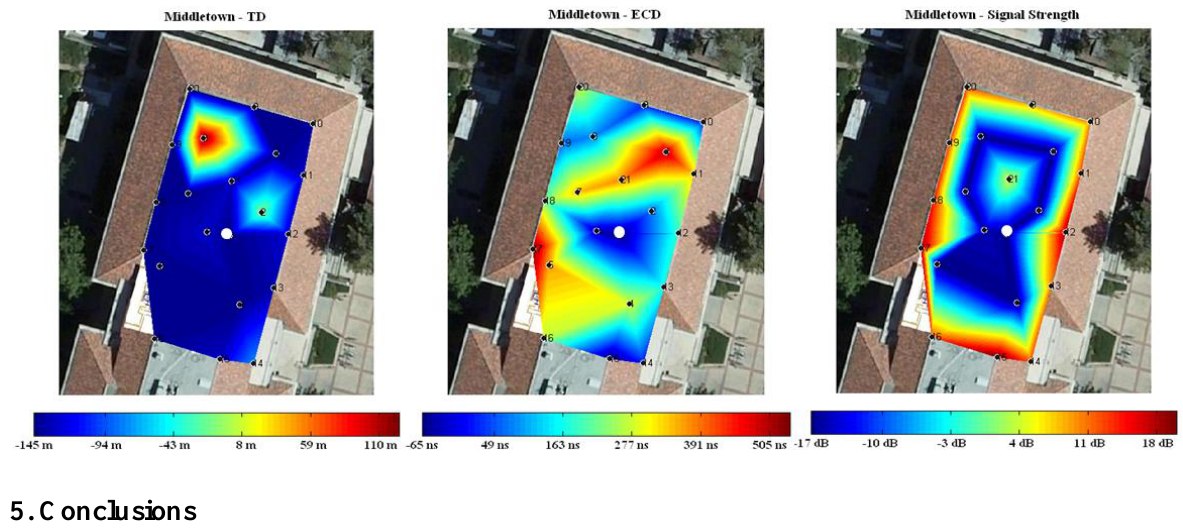
Figure 9. Spatial variation of location data from Middletown in Durand building: (a) TD; (b) ECD; (c) Signal